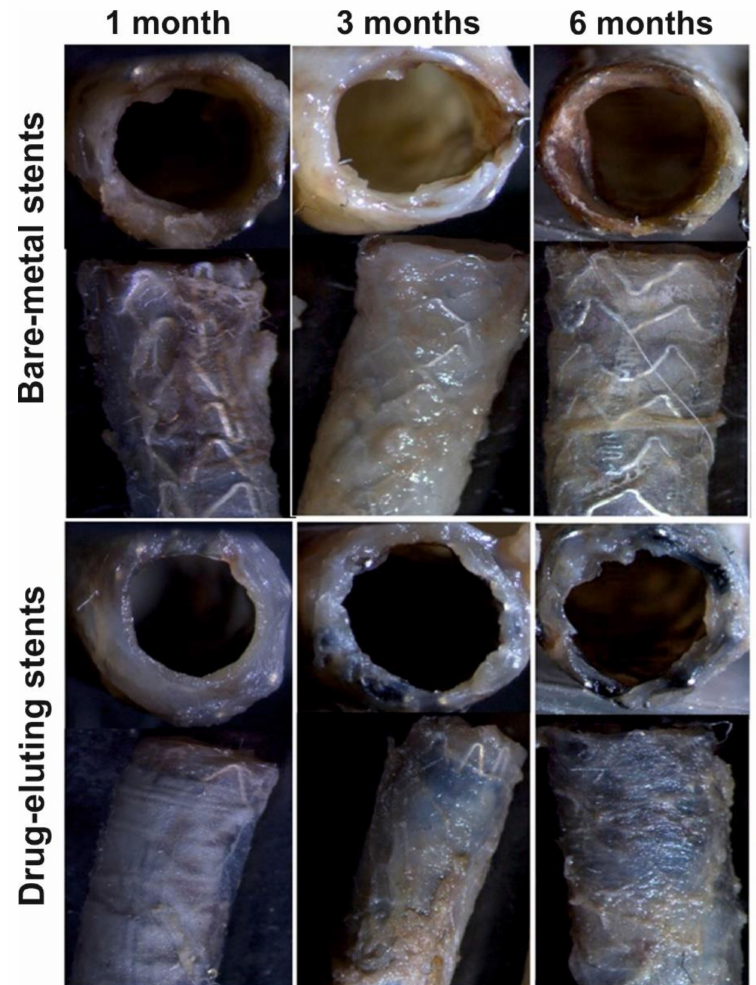
Figure 5. Survey microscopy of the vessels with implanted stents at di ff erent time points of observation. Images obtained using SteREO Discovery V12 microscope (Carl Zeiss,